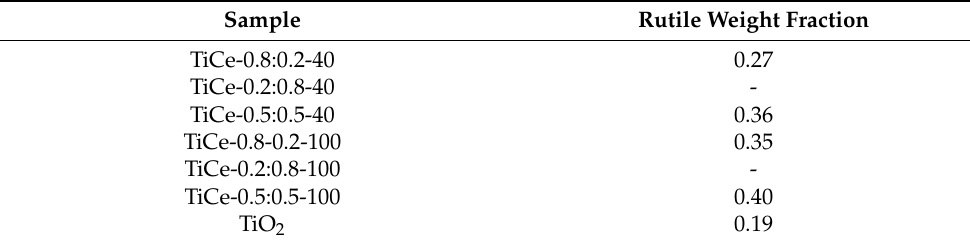
Table 4. The weight fraction of rutile in the mixtures and starting TiO 2